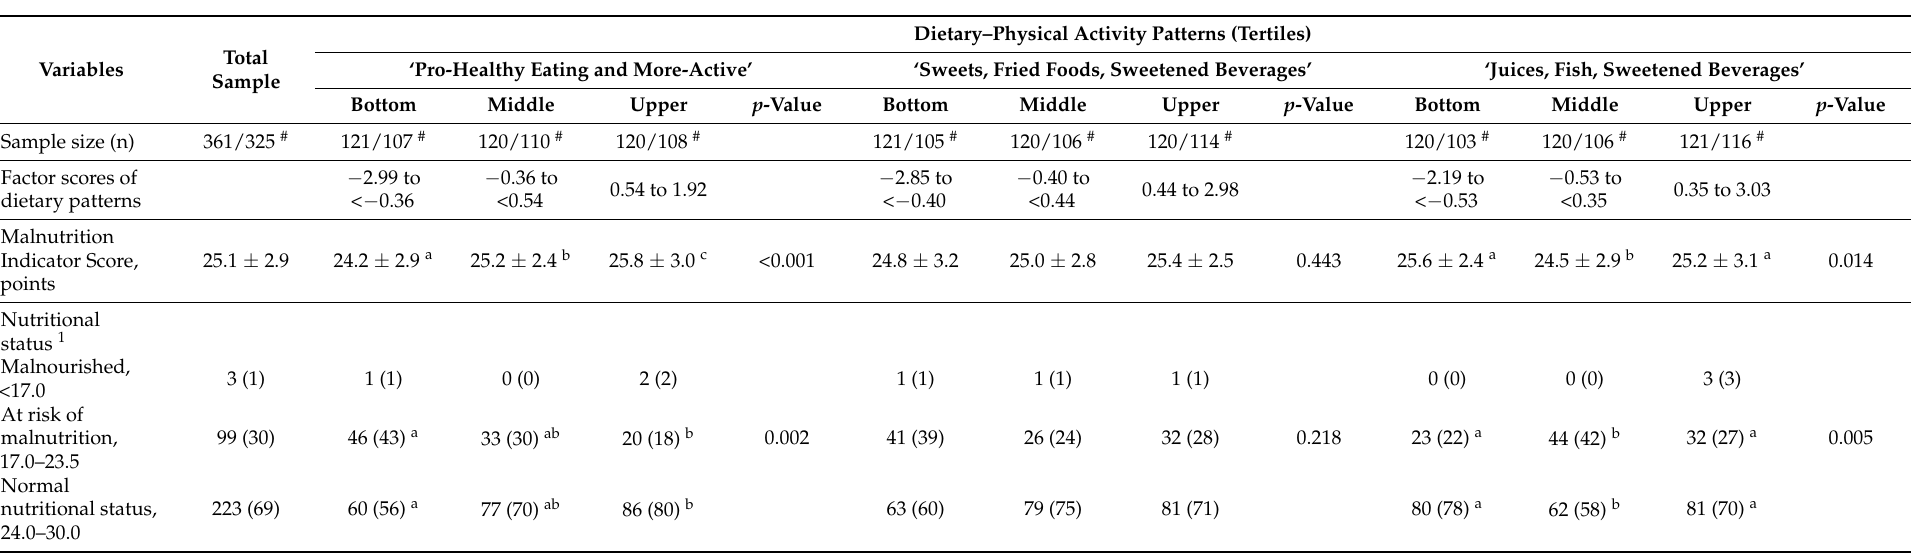
Table 5. Dietary–physical activity patterns (D-PAPs) and health-condition outcomes in older Polish adults (sample size and percentage (%) or mean ±